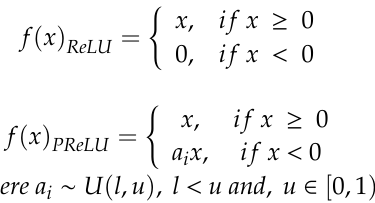
Figure 3. The curve of ReLU and PReLU equations.